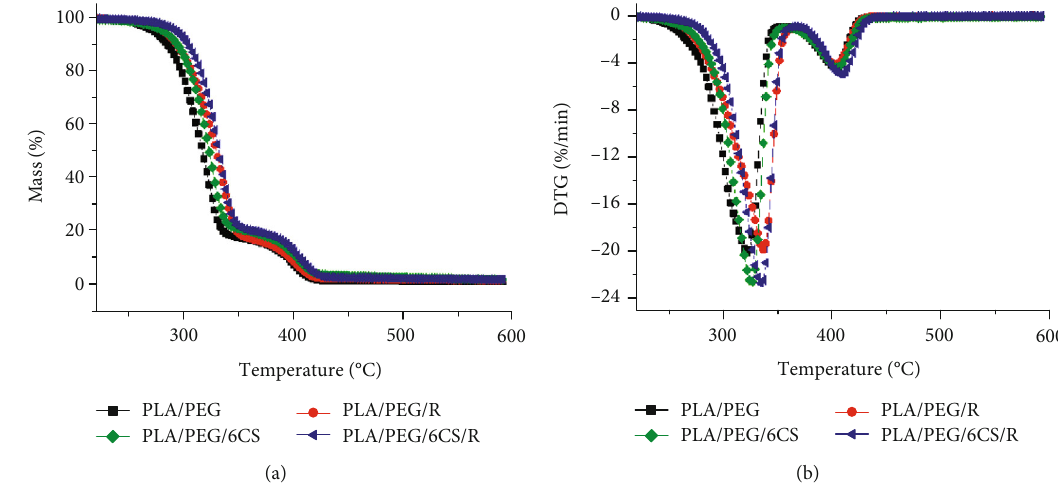
Figure 5: TG (a) and DTG (b) curves for PLA-based blends and biocomposites containing PEG, chitosan, and rosemary ethanolic